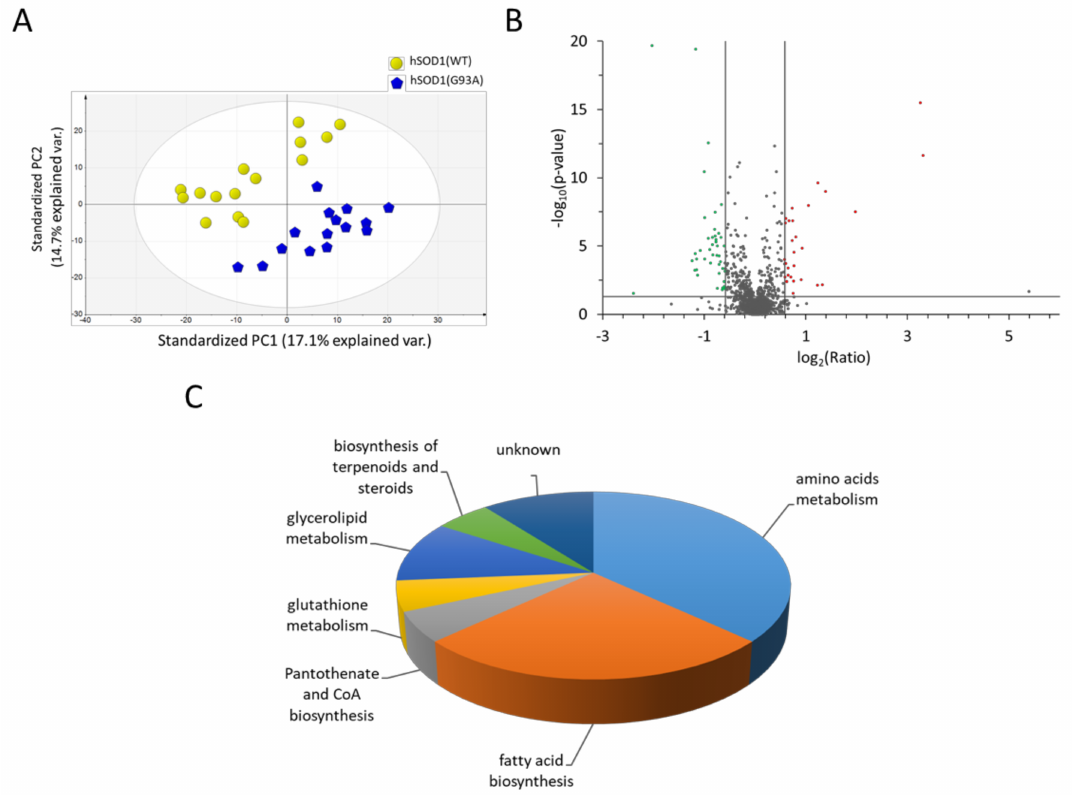
Figure 1. UHPLC-HRMS approach unveils the alteration of metabolite abundance in the CM of hSOD1(G93A) primary spinal astrocytes. ( A ) Principal component analysis (PCA) score plot of CM metabolomics from hSOD1(WT) (yellow circles) and hSOD1(G93A) (blue pentagons) primary astrocyte cultures. Data were acquired by HILIC-HRMS in negative ionization mode. The percentage of variance explained by the first two principal components (PC1 and PC2) is reported in the PCA score plot. Ellipse: Hotelling’s T2 (95%). ( B ) Volcano plot depicting the distribution of the 779 compounds detected in the negative ionization polarity. The abundance of metabolites (expressed as the log 2 (G93A vs. WT ratio)) and the statistical significance (expressed as the − log 10 ( p -value)) were used as representing criteria for the x - and y -axis, respectively. A ratio <0.66 and >1.5, and p -values < 0.05 were used as cut-off parameters (grey circles, non-altered metabolites; green circles, underrepresented metabolites in hSOD1(G93A); red circles, overrepresented metabolites in hSOD1(G93A)). ( C ) Pie chart representing the distribution of significantly altered KEGG pathways between hSOD1(WT) and hSOD1(G93A) astrocytes (other details are reported in Supplementary Table